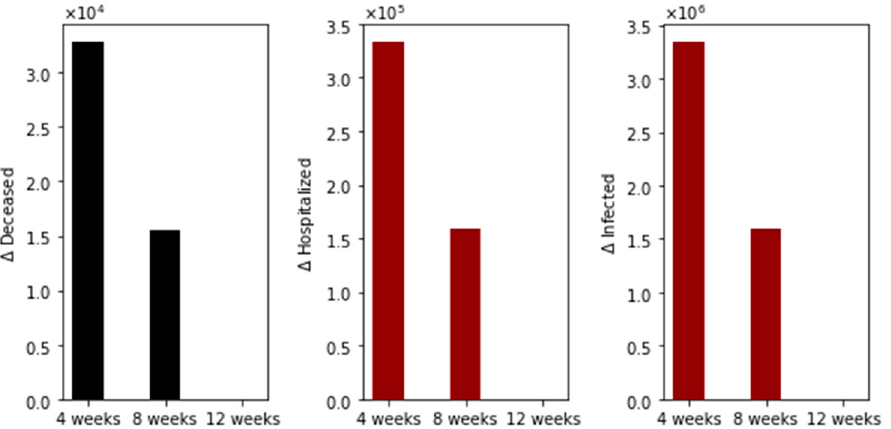
Figure 3. Differences in the total number of deaths, hospitalized, and infected, under different time interval vaccine regimens. This scenario considers a transmission rate such that the basic reproduction number R 0 is greater than one, the vaccination pace is 2 million per day, and the vaccine efficacy after the first dose is 60% and 95% after the